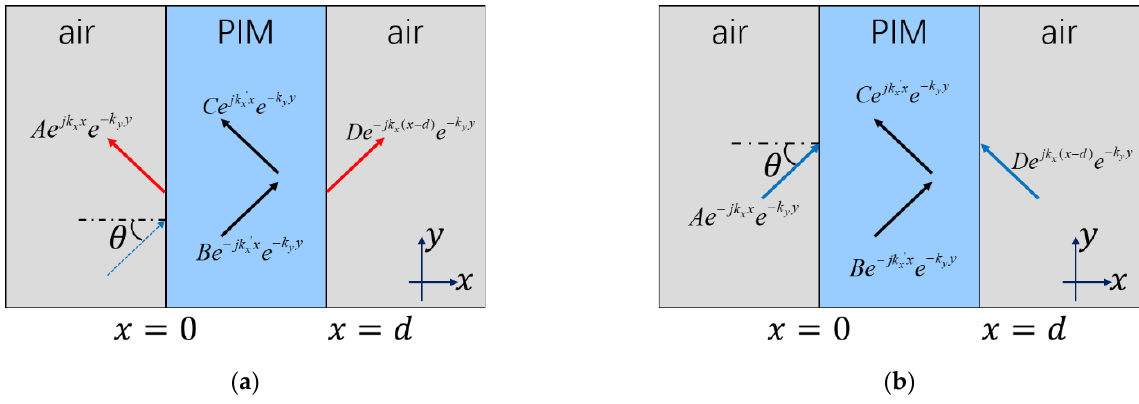
Figure 1. Sketch of the scattering process of ( a ) laser and ( b ) CPA modes in PIM slabs. The blue rays indicate the incident waves, while the black and red rays indicate the scattered waves in the PIM slab and background medium, respectively.